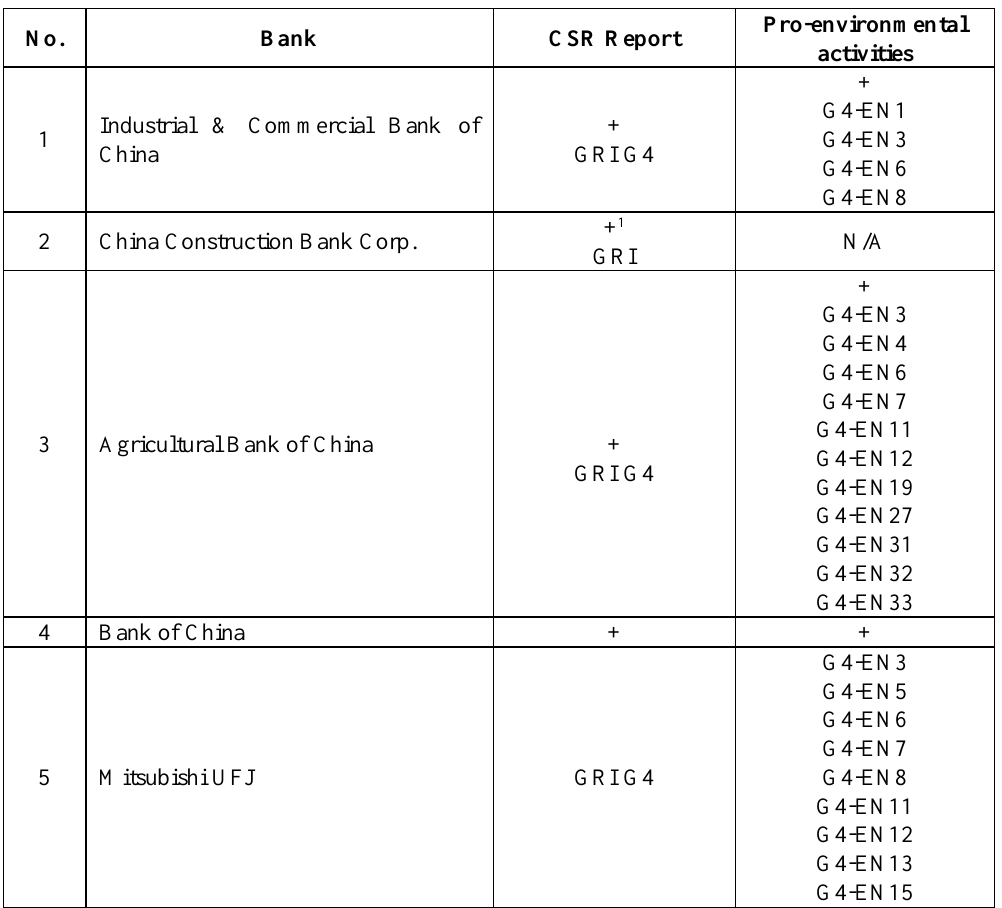
Table 2. CSR reports by the world’s largest